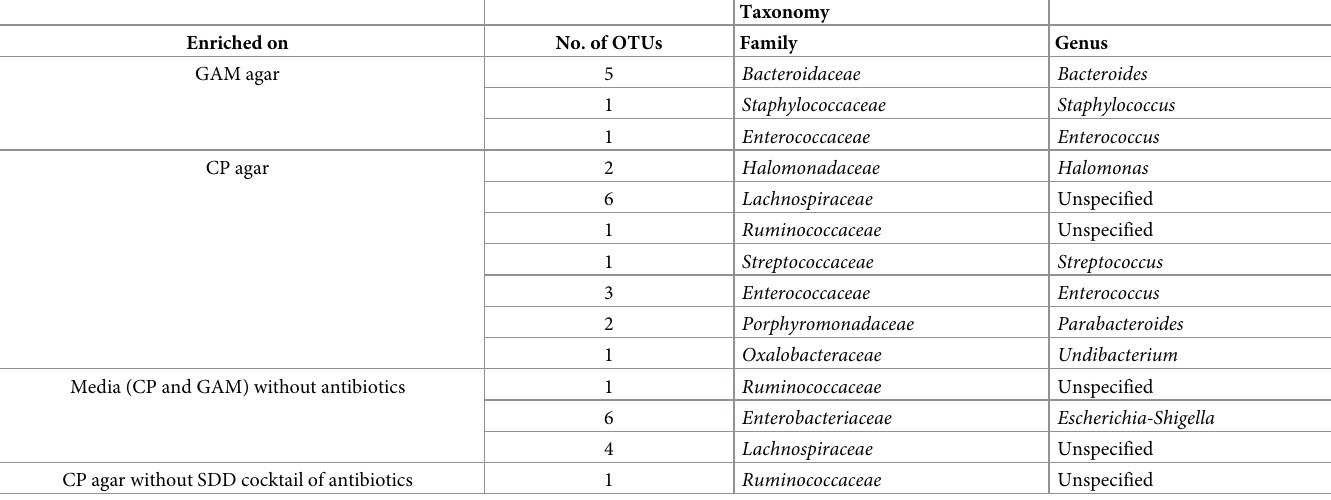
Table 1. Linear mixed-effect models of OTU-level composition data of bacterial growth were applied to investigate which OTUs varied in abundance as a results of cultivation